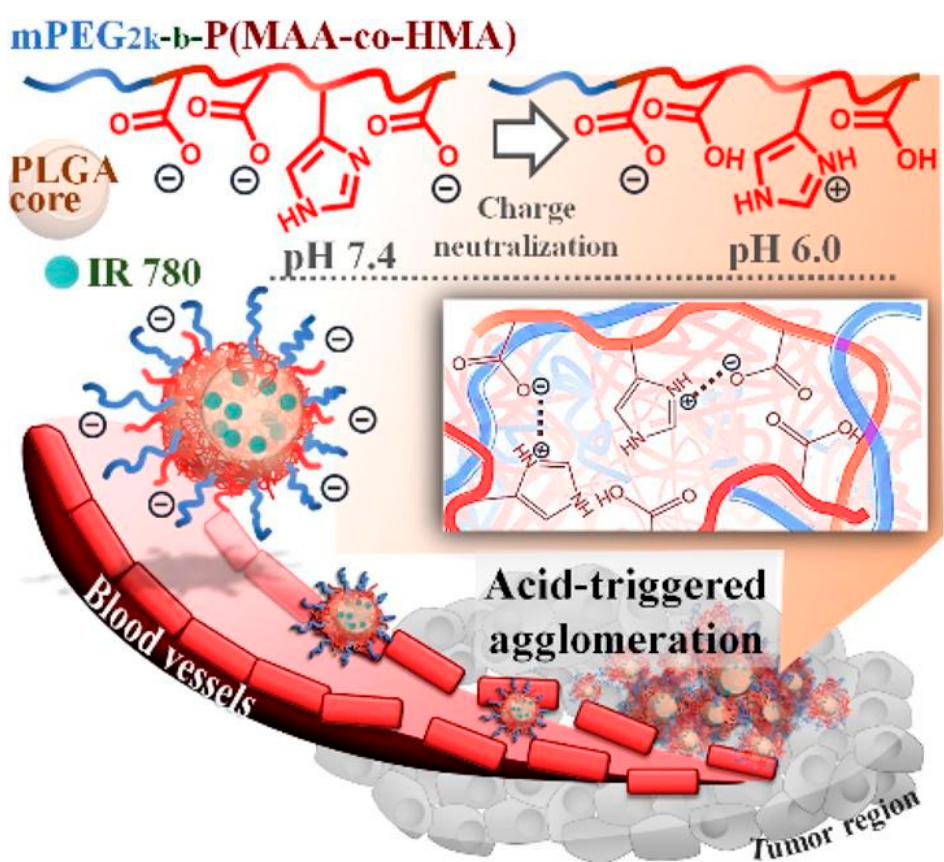
Figure 8. Schematic representation of the enhanced tumor retention of nanovehicles designed by Lu et al. by virtue of acid-triggered surface charge neutralization and agglomeration. Reprinted with permission from [103]. Copyright 2020, Elsevier.